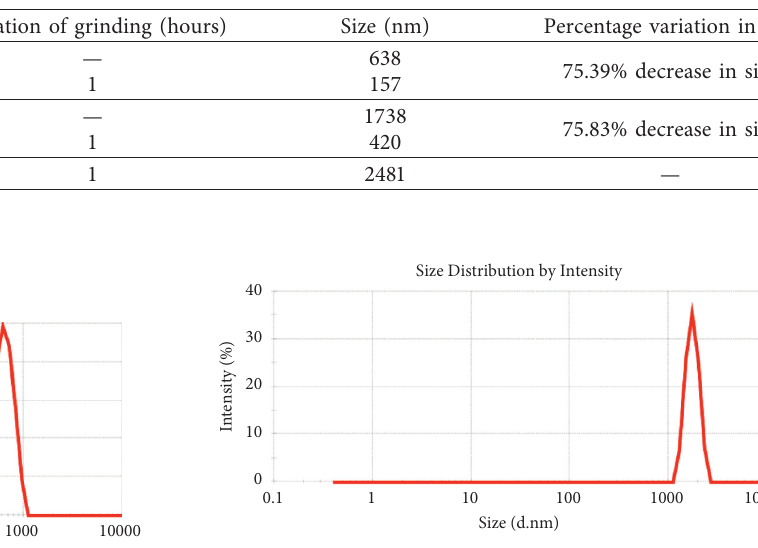
Figure 6: Specimens for the sorptivity test. Table 4: Reduction in size after grinding.